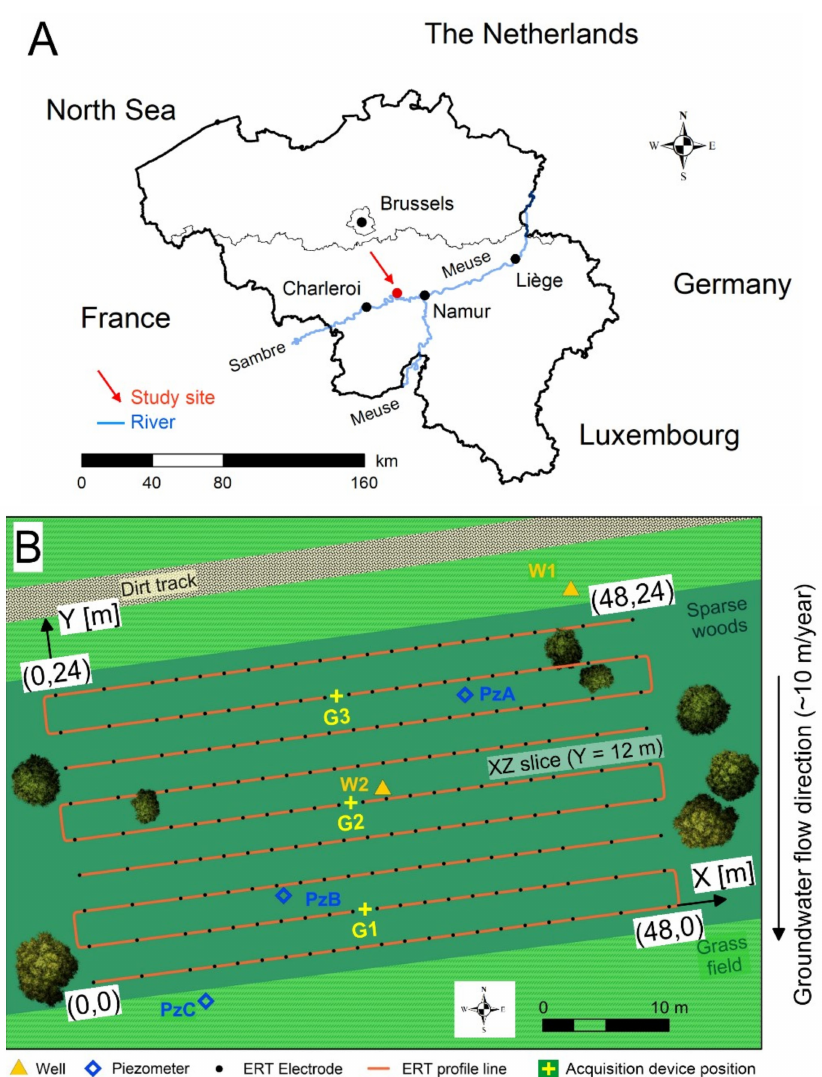
Figure 1. Location of the experimental site in an old alluvial plain of the Sambre River in Wallonia, Belgium ( A ). The experimental setup ( B ) shows the location of wells (W1 and W2) and piezometers (PzA, PzB, and PzC) equipped with CTD divers for water level (D), groundwater temperature (T), and specific electrical conductivity (C) measurements. The 3D ERT (electrical resistivity tomography) setup is composed of nine ERT profile lines and 189 electrodes in total (modified after